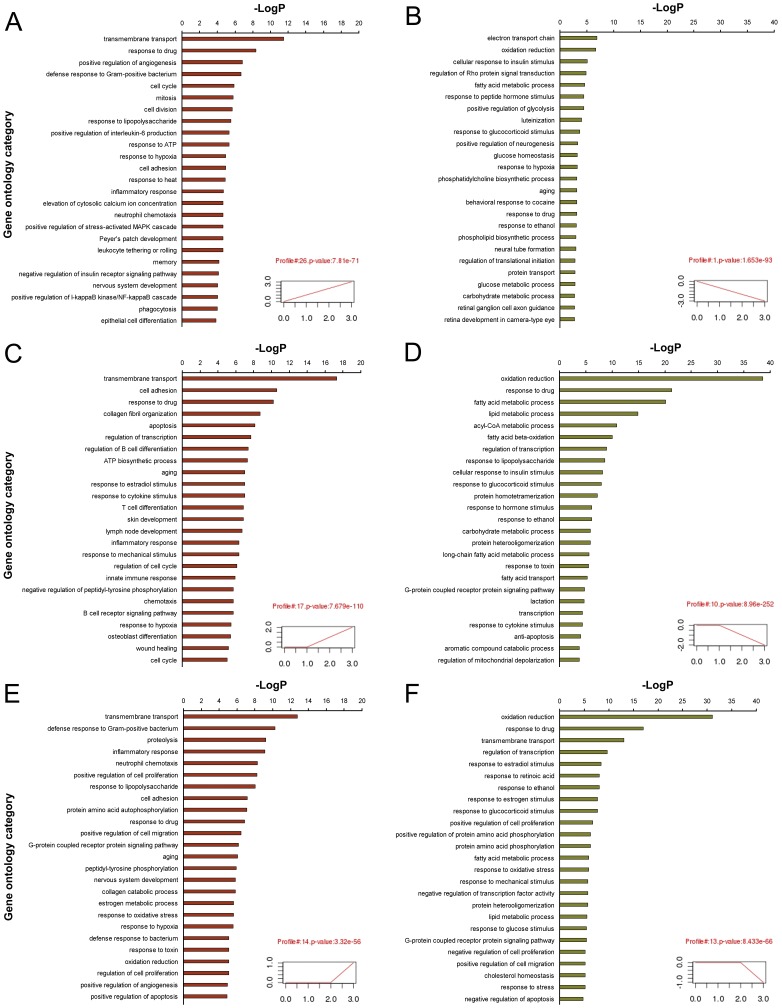
GO category analysis of significant cluster profiles in murine liver duringS. japonicum infection.(P value <0.05, FDR <0.05, only the top 25 GO categories were shown). (A and B) The significant GO categories for consistently up-regulated (cluster profile 26) and down-regulated (cluster profile 1) genes during infection, respectively. (C and D) The significant GO categories for up-regulated (cluster profile 17) and down-regulated (cluster profile 10) genes followed by egg deposition, respectively. (E and F) The significant GO categories for up-regulated (cluster profile 14) and down-regulated (cluster profile 13) genes in the late phase of infection, respectively.